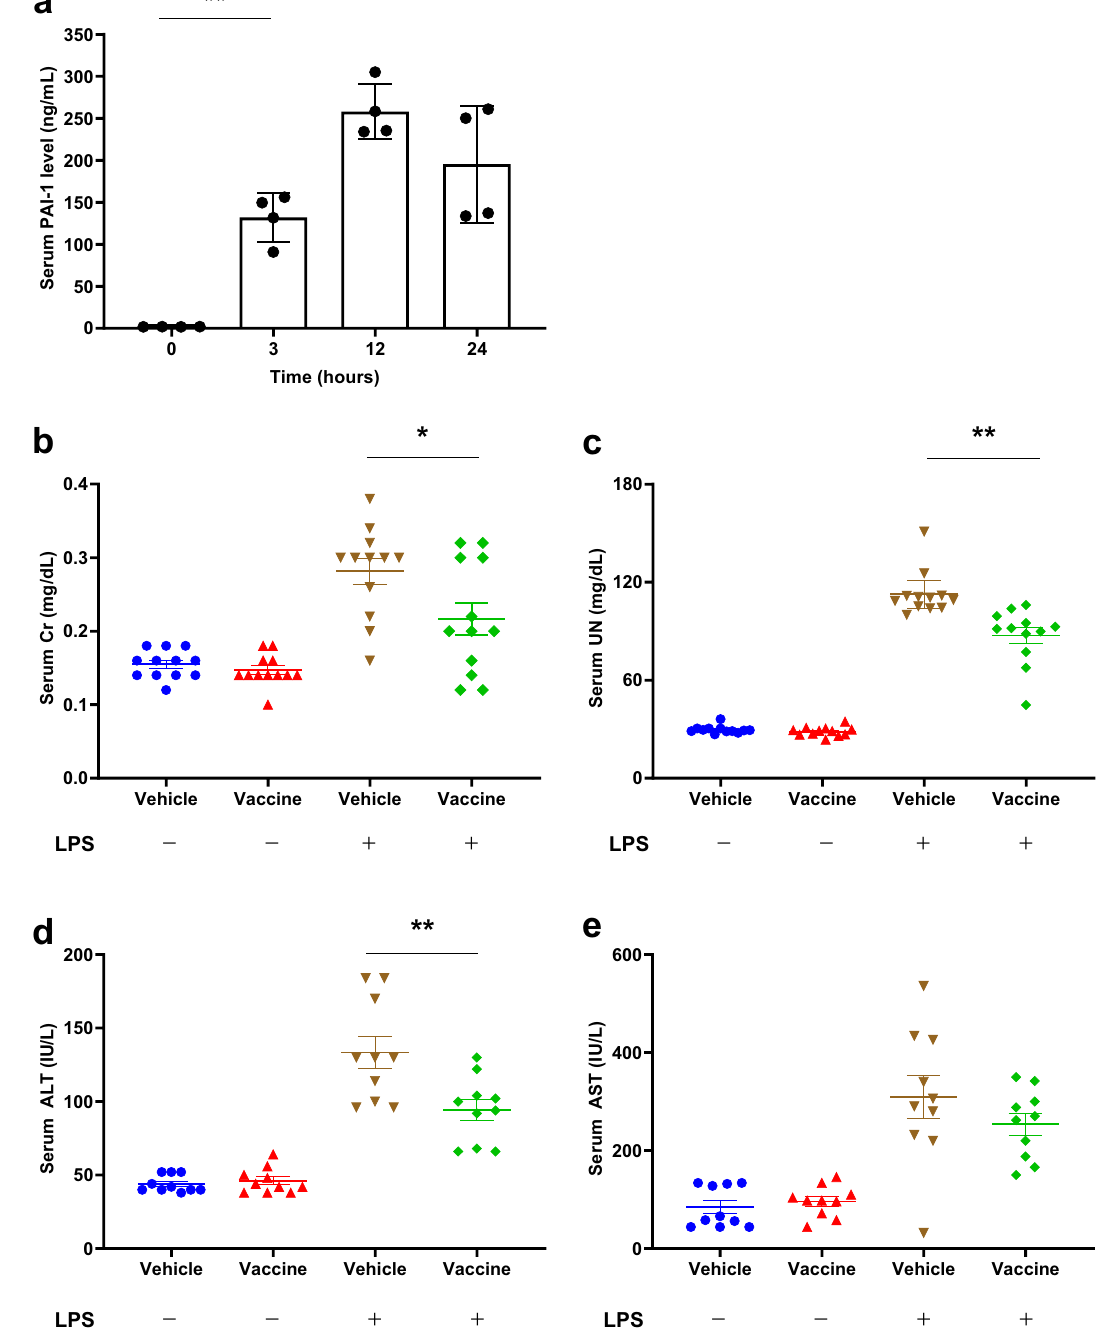
Figure 2. Effects of PAI-1 vaccine on organ function in a mouse model of LPS-induced sepsis. ( a ) Serum samples were obtained from non-immunized mice ( n = 4 per group) before and at 3, 12, and 24 h after challenge with 6 mg/kg LPS, and serum PAI-1 levels were measured. ( b–e ) Mice ( n = 8 per group) were immunized with the PAI-1 vaccine or KLH vehicle and then injected with or without 6 mg/kg LPS. Serum samples were obtained 24 h after LPS challenge, and creatinine (Cr), urinary nitrogen (UN), alanine aminotransferase (ALT), and asparagine aminotransferase (AST) levels were measured. Data are expressed as mean ± SEM (error bars). Significant differences in serum PAI-1 levels between before and 3 h after LPS administration, and in biomarkers of organ damage between the LPS-challenged vaccine and vehicle groups were determined by using Student’s t -test. ** P < 0.01; * P < 0.05 compared with the value before LPS administration or for the LPS-challenged vehicle- treated